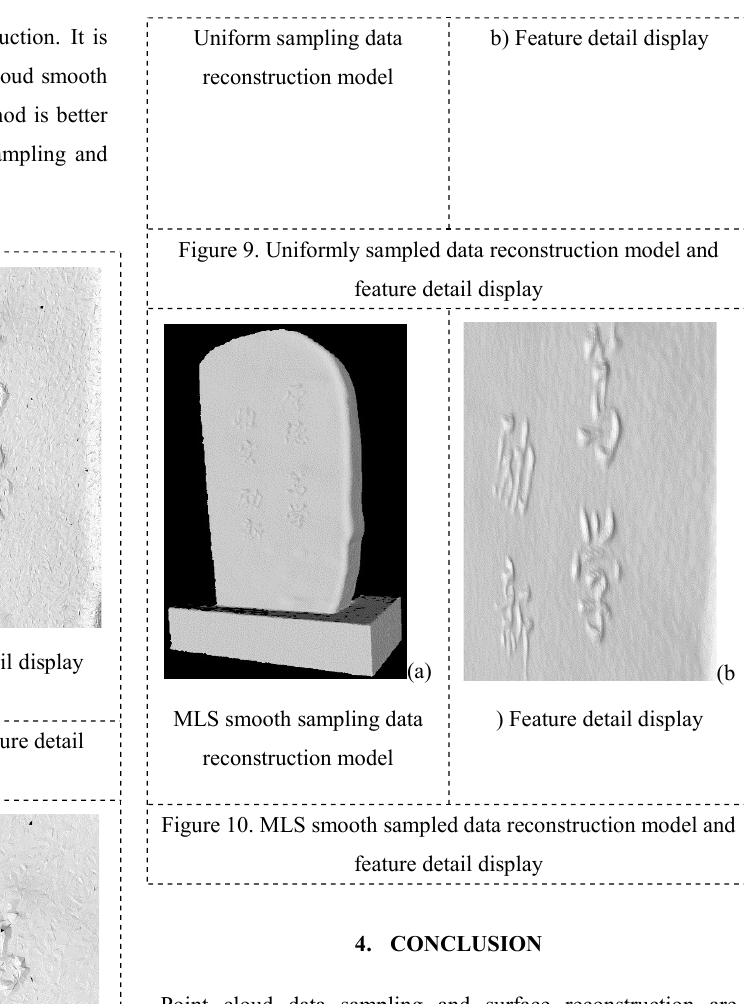
Figure 10. MLS smooth sampled data reconstruction model